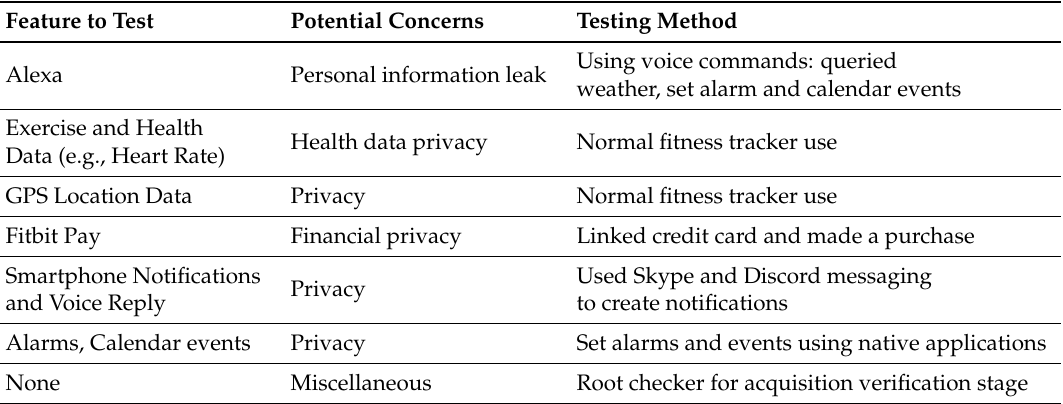
Table 1. Fitbit Versa 2 Fitness Tracker Features and Testing